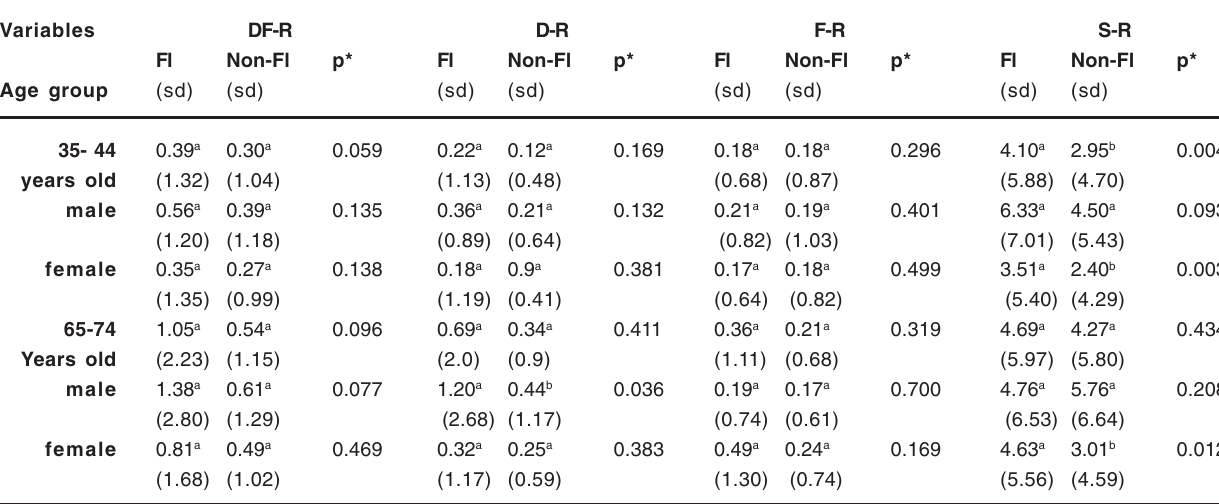
TABLE 3- Root condition according to age group, gender and fluoridated (Fl) and non-fluoridated (Non-Fl) water. Southeast Region of São Paulo State .